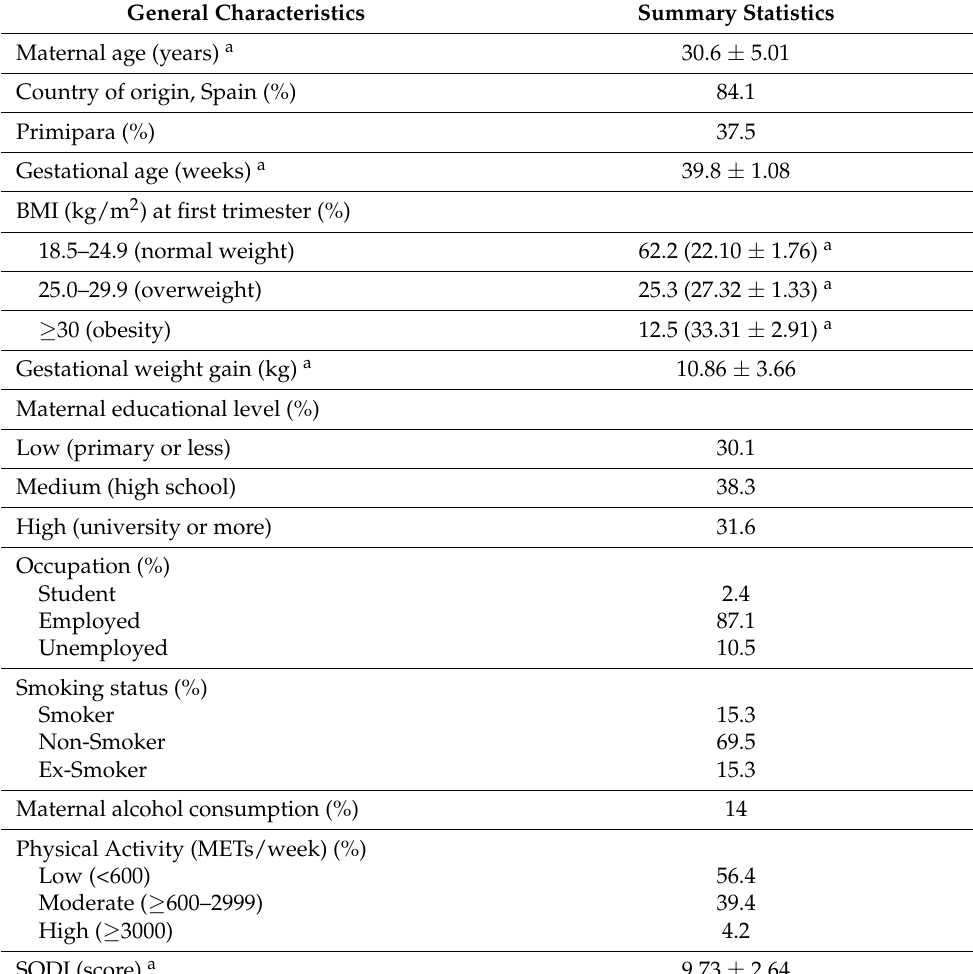
Table 1. Sociodemographic and lifestyle characteristics of pregnant women ( n =